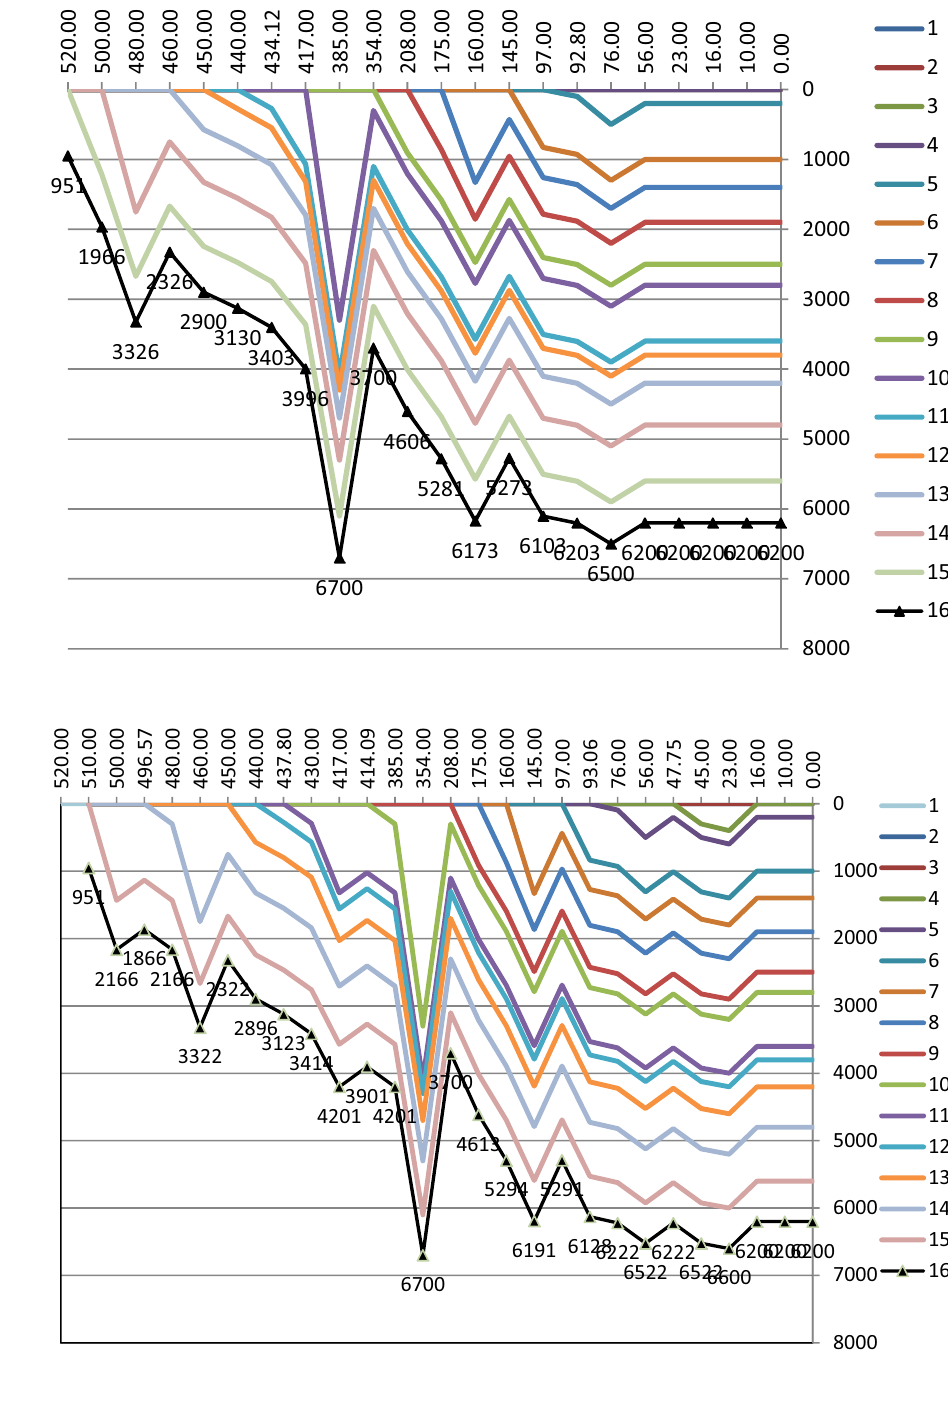
Fig. 5 Curve chart of burial his- tory for strata 2